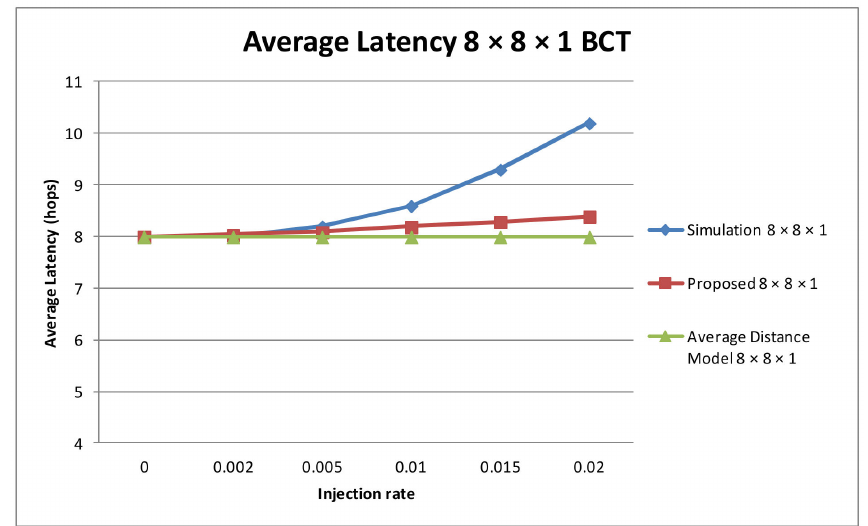
Figure 10. Average estimated latency vs. flit injection rate comparison between simulation, the proposed model and the average distance model for three NoC topologies and bit-complement traffic.